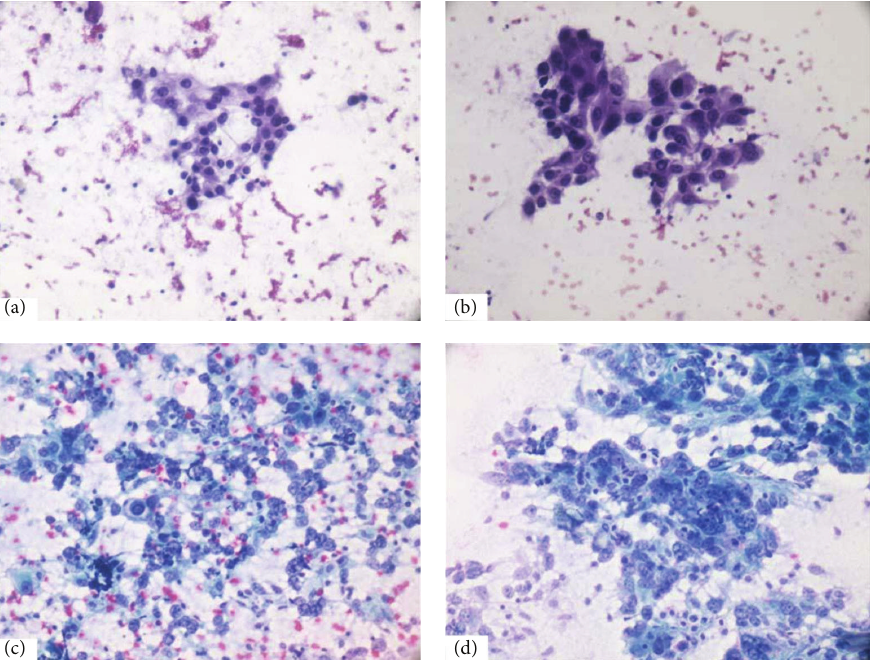
Figure 4: (a) Loosely cohesive cluster of mild pleomorphic ductal epithelial cells with mild nucleomegaly, smooth nuclear envelope, and indistinct nucleoli—Robinson’s cytological grade I (PAP, × 400). (b) Moderately pleomorphic ductal cells with slightly irregular nuclear membrane and noticeable nucleoli. Nuclei are 3-4 times the size of erythrocytes—Robinson’s cytological grade II (PAP, × 400). (c and d) Robinson’scytologicalgradeIII—markedlypleomorphicdiscohesivesinglyscatteredtumorcellswithmarkednucleomegaly,irregularnuclear membrane, prominent abnormal nucleoli, and coarsely clumped nuclear chromatin ((c) PAP, × 400; (d) PAP, ×